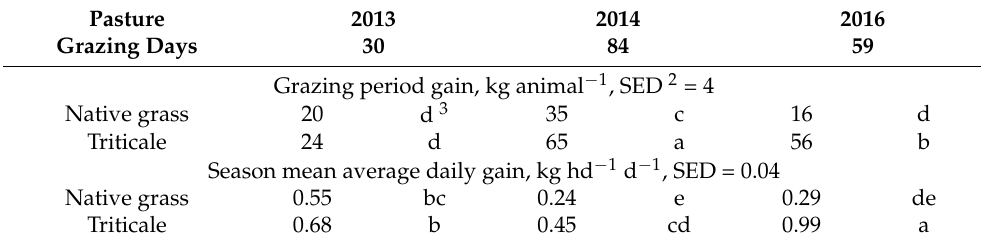
Table 5. The year × pasture interaction for grazing period 1 total gain and average daily gain of growing beef stockers grazing supplemented dormant native grass, or triticale in three late-winter periods at Tucumcari, NM, USA. Values are the means of two pasture